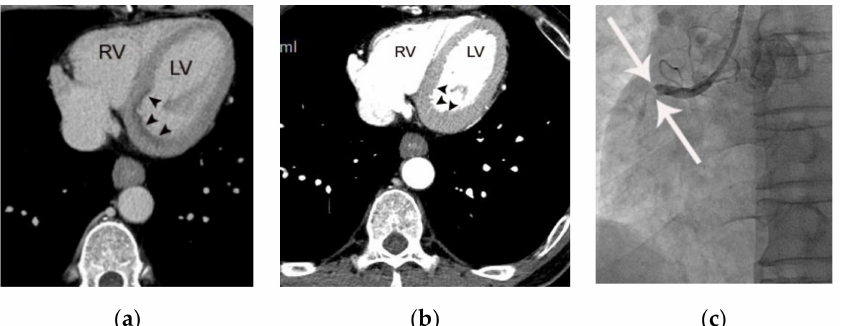
Figure 14. A case of acute myocardial infarction in a 60-year-old male patient with hepatocellular carcinoma identified on non-ECG gated CT. ( a ) Abdomen CT was performed in this patient for routine follow-up of hepatocellular carcinoma. Note the typical subendocardial hypoattenuation without myocardial thinning (arrowheads) in the right coronary artery territory (basal left ventricle). HU of the low and normal attenuation areas in the left ventricle were 45 and 109, respectively. The constellation of CT findings was consistent with AMI in the right coronary artery territory, although there was no corroborating information regarding clinical history, ECG, and troponin level. ( b ) Note the normal attenuation in the same area (arrowheads) on an axial CT image 2 months previously. The ED physician was notified of the CT findings and subsequently confirmed ischemic ECG changes and an elevated troponin level. ( c ) Emergent coronary angiography confirmed total occlusion of the proximal right coronary artery (arrows), and subsequent revascularization was